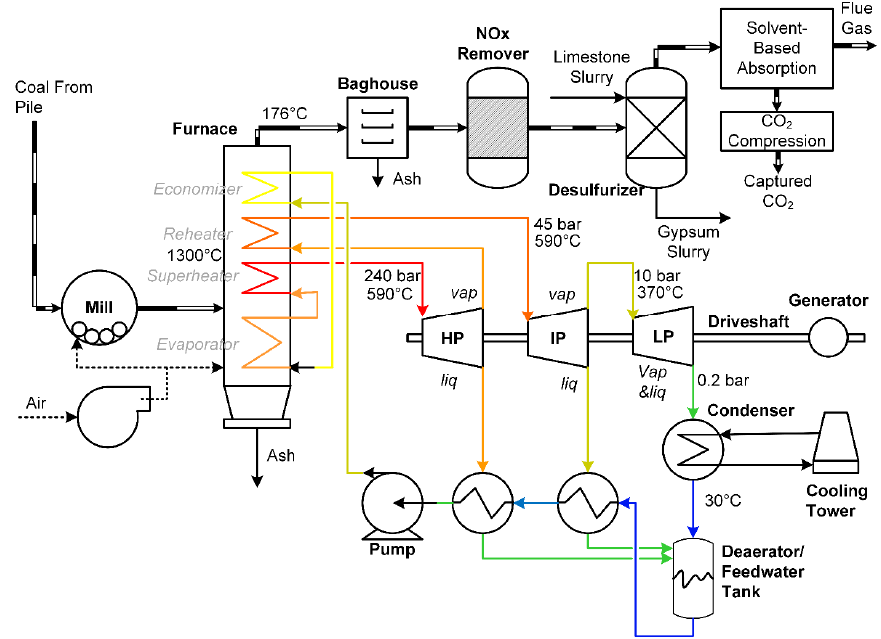
Figure 1. A typical schematic of a supercritical pulverized coal (SCPC) process with post ‐ combustion carbon capture. Adapted from a combination of [6,10]. Processes 2017 , 5 , 44